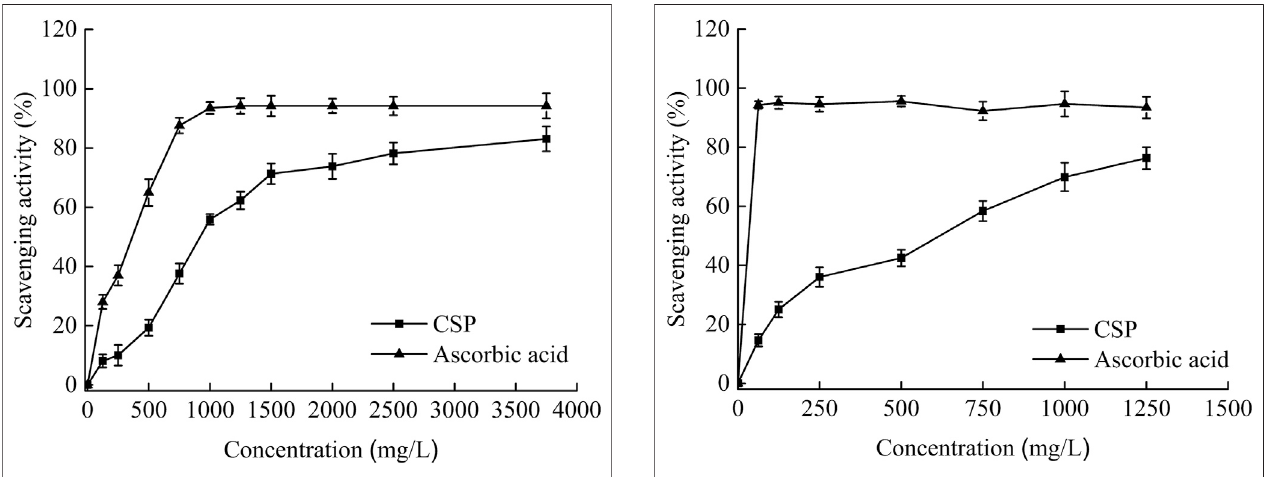
FIGURE 4 | Scavenging effects on DPPH radicals of CSP.